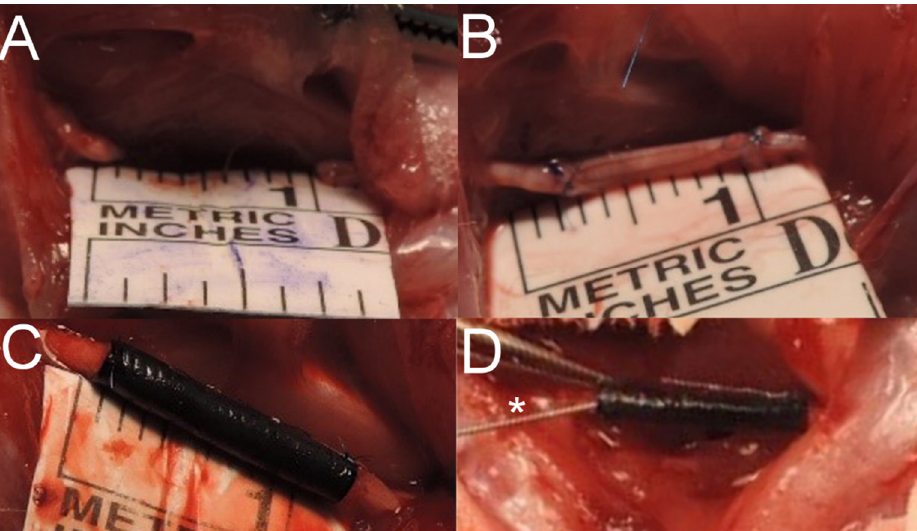
Figure 13. Intraoperative photograph of each experimental group. ( A ) After excision of 10 mm trunk of the sciatic nerve 10 mm gap remained, and the length was confirmed with a millimeter ruler; ( B ) Excised trunk was rotated and sutured to the nerve stumps with two 10/0 Prolene epineural sutures; ( C ) P(LLA-CL)-COL-PANI conduit filled the gap, nerve stumps were placed 2 mm into the lumen of the conduit and secured with two 10/Prolene epineural sutures; ( D ) In Group D, after the ASCs were seeded in the conduit, an implantation injection of 1 × 10 6 ASCs was made into the lumen of the conduit (*—needle for ASC